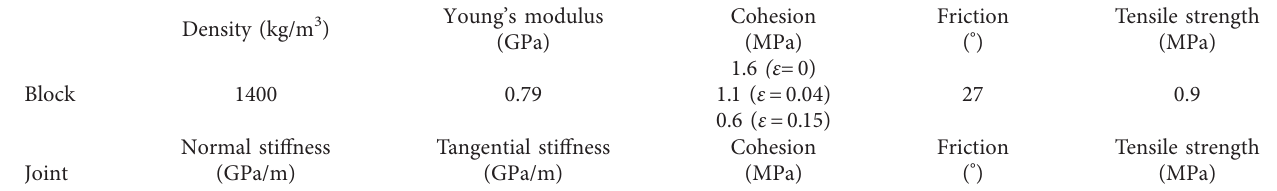
Table 2: Calibrated mechanical parameters of blocks and joints of the coal.